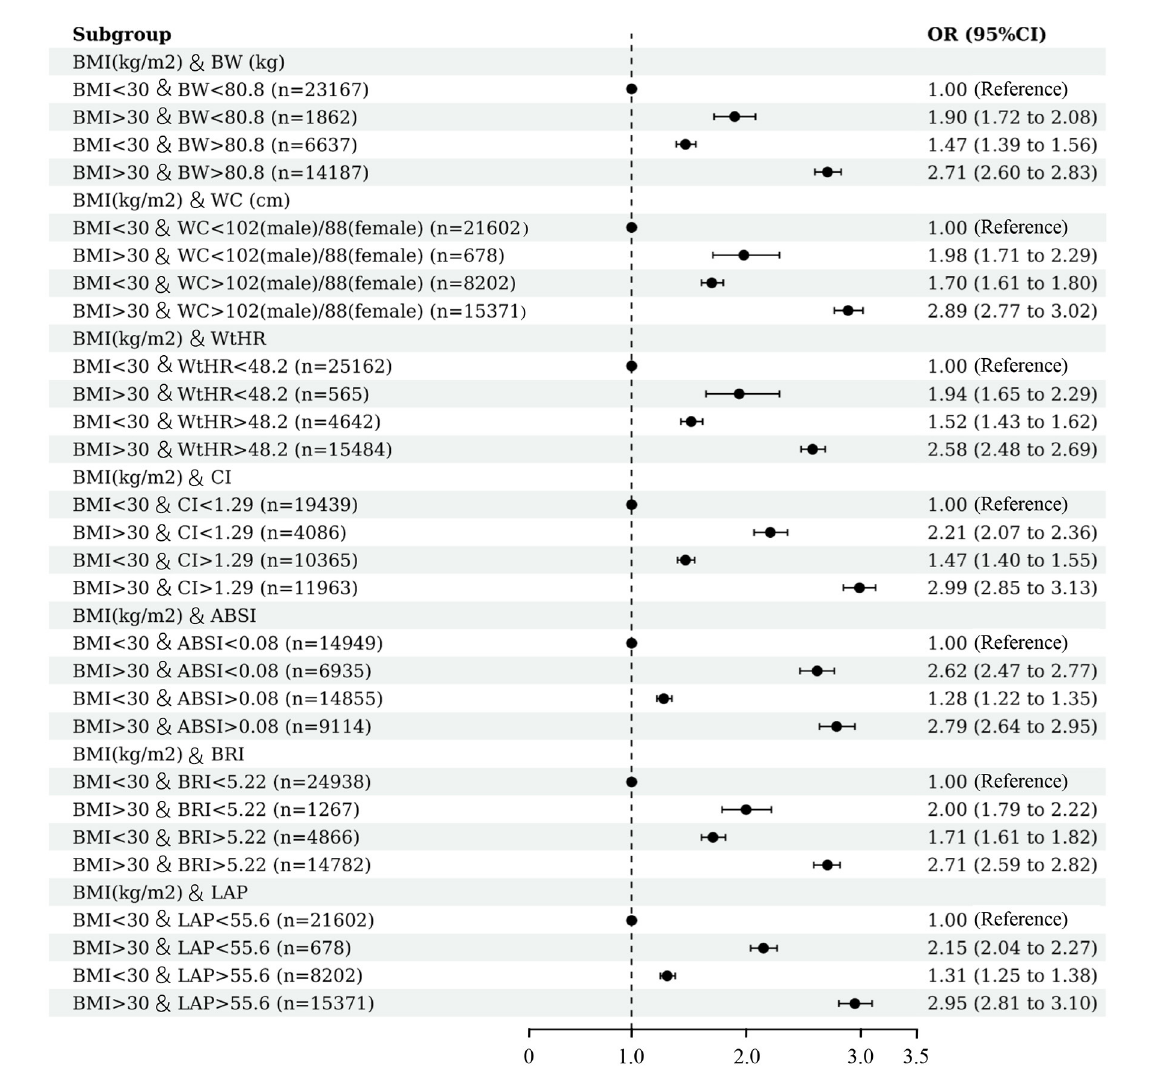
FIGURE4 Association between hypertension and combined anthropometric indices. Multivariable logistic regression was conducted after adjusting for confounding factors of age, sex, race/ethnicity, education, smoking, drinking, diabetes, and